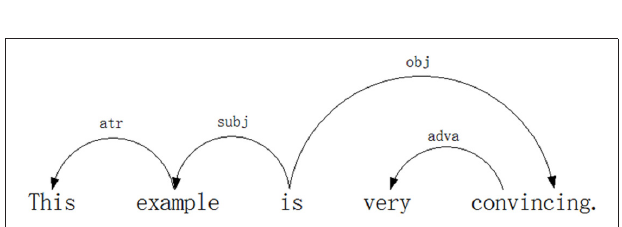
FIGURE 2 | Dependency analysis of the sentence “ This example is very convincing